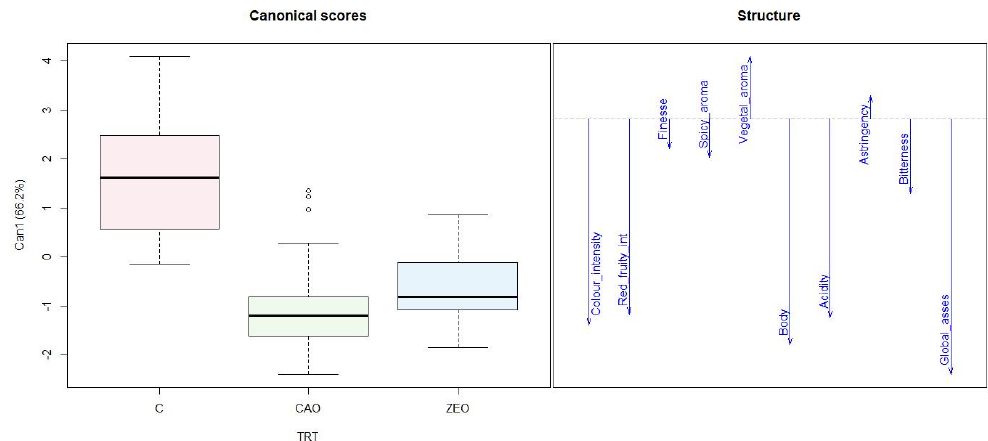
Figure 4. Boxplot of canonical scores (Can 1) and a vector diagram showing the magnitude of structure coefficients related to the sensory traits of Sangiovese wines obtained from kaolin (CAO) and chabasite-rich zeolitite (ZEO) treatments or the control (C) vines in 2020.